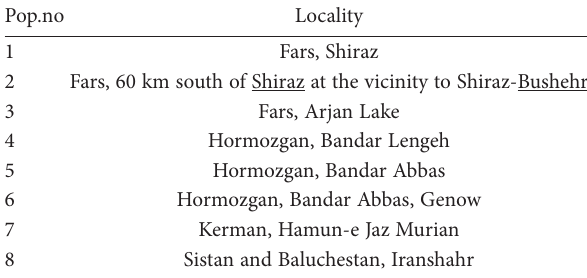
Table 1. Populations studied their locality and ecological features.